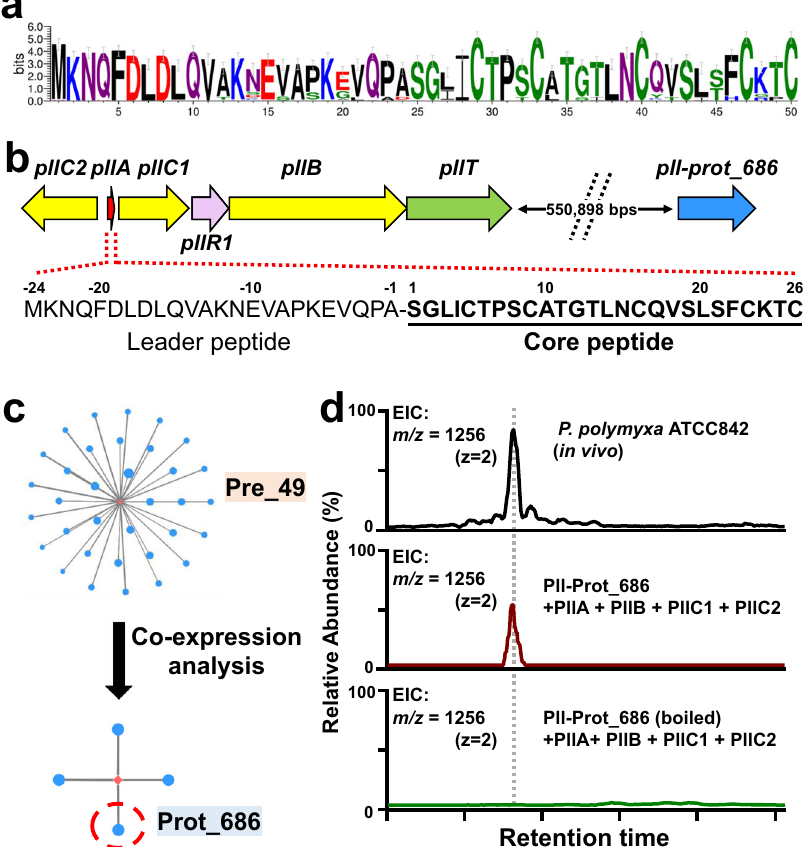
Fig. 2 Identi fi cation of a hidden protease from Prot_686 for maturation of paenilan. a Sequence logo of the group Pre_49. Sequence alignments were trimmed by trimAl to remove gap-rich regions before drawing logo. Error bars indicate sample correction, and the total height of the error bar is twice this correction. b A representative BGC of Pre_49 in P. polymyxa ATCC 842 that presumably producing paenilan based on the precursor sequence. All 44 BGCs of this group do not harbor any protease-encoding genes, suggesting hidden proteases encoded elsewhere in the genome. Dashed lines separating pllT and prot_686 indicate a gap in their respective genetic locations. This type of notation is also used in other fi gures below. The distance of this gap, 550,898 base pairs, is represented here to convey magnitude. c Intersection of precursor-protease correlation ( ρ > 0.3, pAdj < 1E − 5, one-sided t -test, adjusted by false-discovery rate, I ≥ 10) and co-expression ( ρ > 0.4, pAdj < 0.05, one-sided t -test, adjusted by false-discovery rate) suggested candidate proteases(s). d LC-MS analysis indicated the proteolytic activity of Prot_686 for the maturation of paenilan. EIC: extracted ion